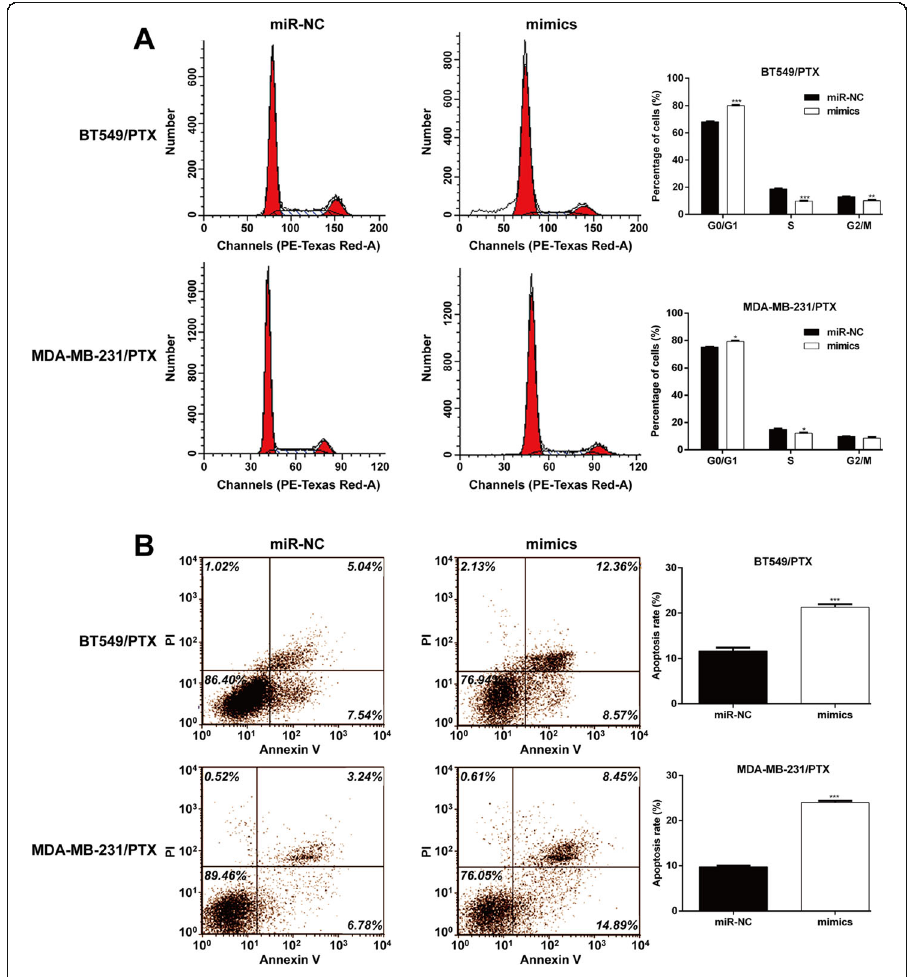
Fig. 3 MiR-5195-3p induced cell cycle arrest and apoptosis of paclitaxel-resistant breast cancer cells. Synthesized miR-5195-3p mimics were transfected into paclitaxel-resistant MCF-7/PTX and MDA-MB-231/ PTX cells. a Representative images of cell cycle distribution are shown in left panel and the statistical analysis of the cell percentage in G0/G1, S and G2/M phases is shown in the right panel. b Representative images of apoptosis are shown in left panel and the statistical analysis of apoptosis is shown in the right panel. * p < 0.05, ** p < 0.01, *** p < 0.001 vs.